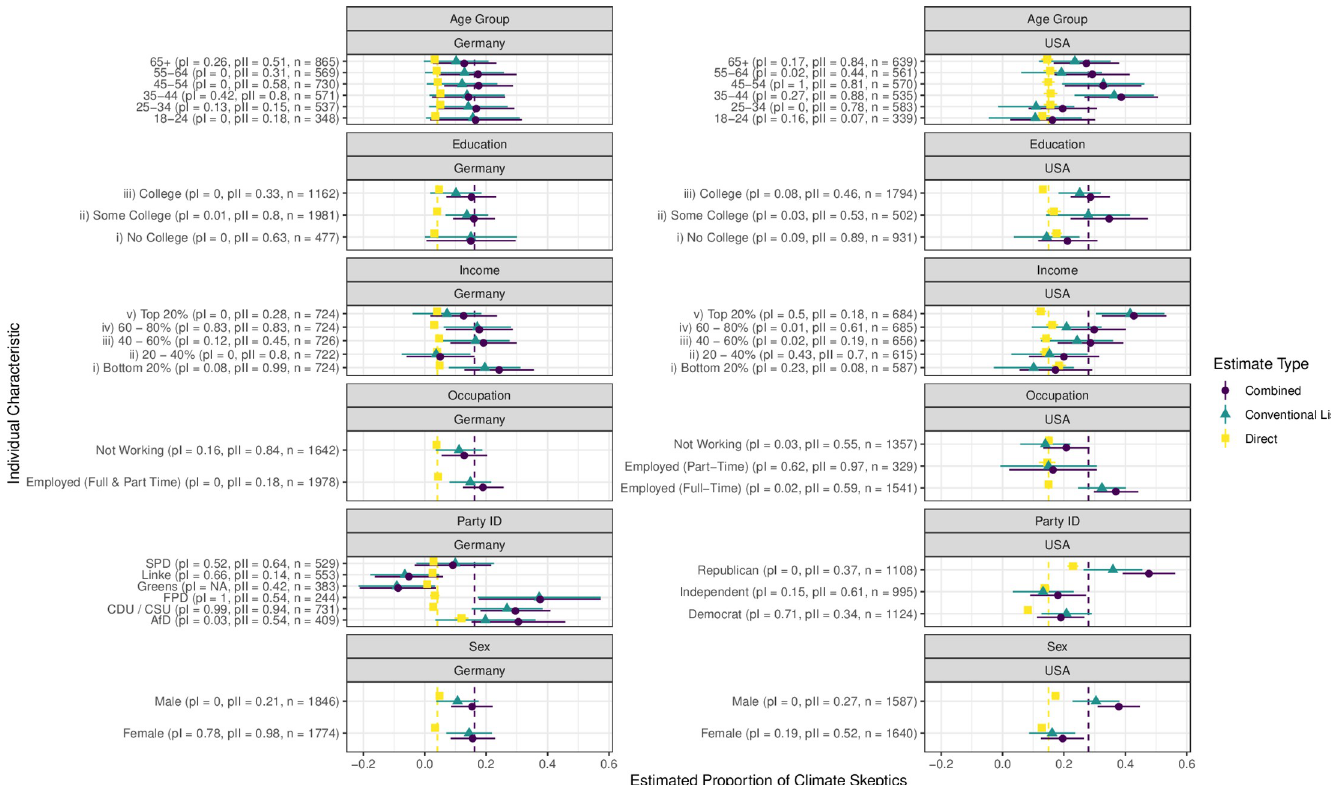
Fig 2. Misreporting of climate change skepticism according to individuals’ characteristics. Each point indicates the estimated proportion of individuals within the relevant sub-sample who believe climate change is in no way caused by humans, dependent upon whether they are asked directly or indirectly (through the list experiment). 83.4% Confidence intervals are displayed, as an 83.4% interval testing for the overlap of two confidence intervals approximates a 95% interval testing for the exclusion of a single value [26]. The light dashed vertical line indicates the average direct estimate and the dark dashed vertical line displays the average combined estimate adjusting for covariates, as previously displayed in Fig 1. pI refers to the placebo test that assesses whether any of the assumptions (Monotonicity, No Liars, No Design Effects, and Treatment Independence) are violated. pII refers to the placebo test that assesses the validity of the Treatment Independence Assumption. Values greater than 0.05 for these tests mean that we fail to reject the hypothesis that these assumptions are